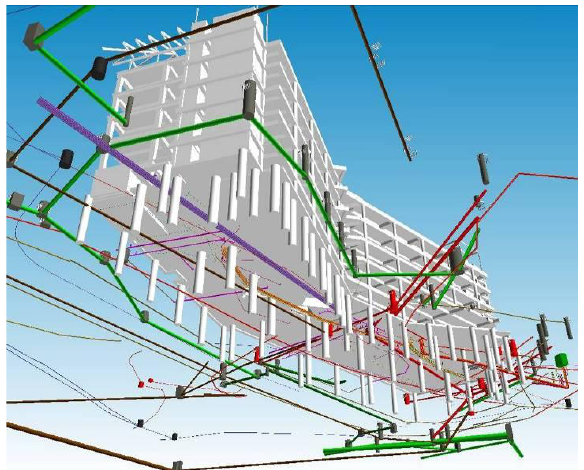
Figure 3 Utilization of BIM Model for Underground Utilities Coordination (Courtesy of: Holder Construction, Atlanta, Georgia,